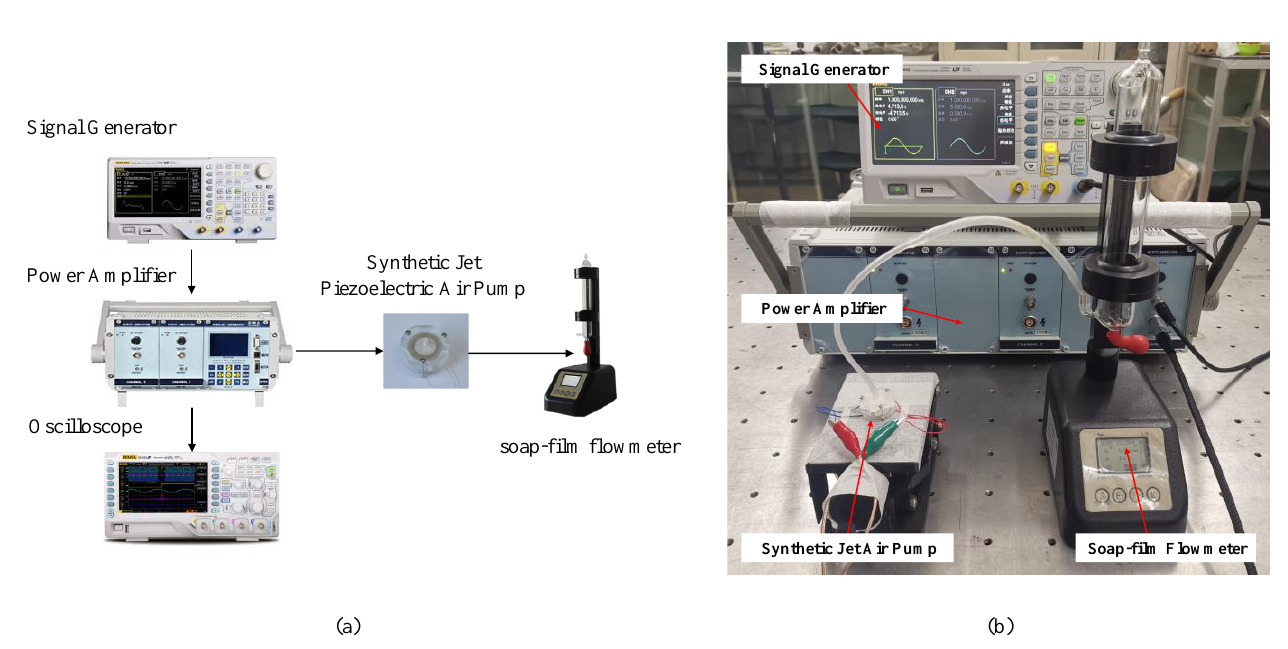
Figure 5. The prototype of the synthetic jet piezoelectric air pump with different inlet channel: ( a ). with direct channel; ( b ) with diffuser/nozzle channel; ( c ) with petal-shaped channel.